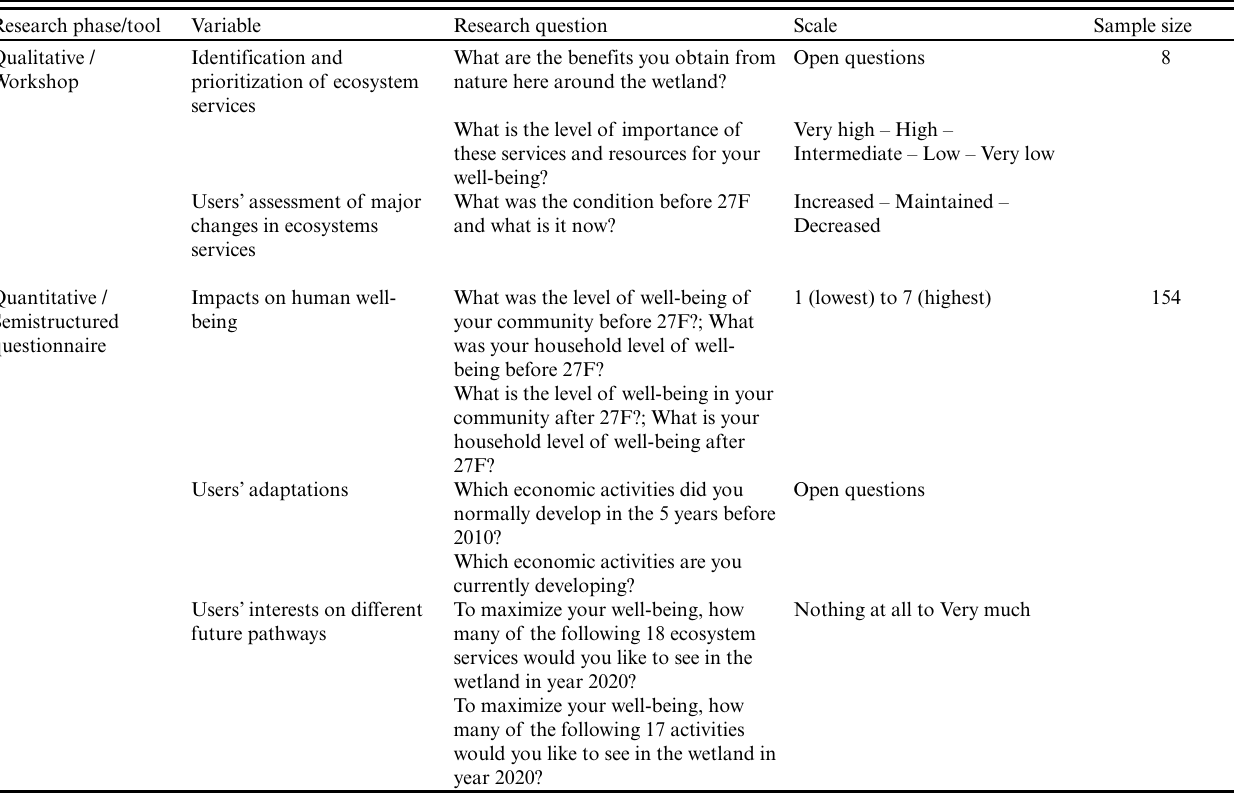
Table 1 . Operationalization of shifting ecosystem services and human well-being as study